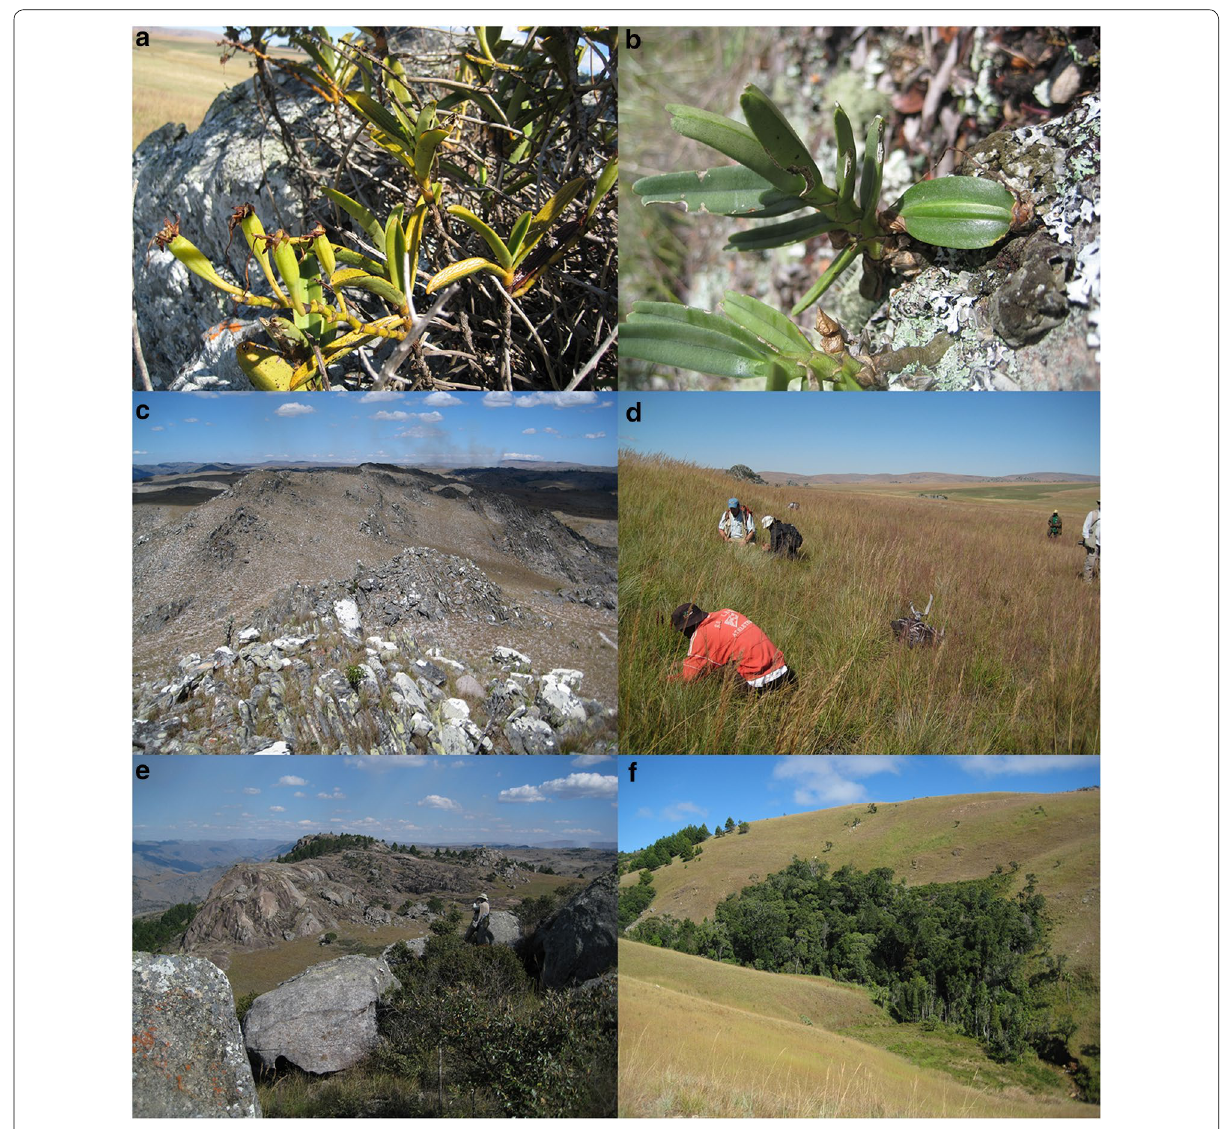
Fig. 1 Orchids and their habitats in Itremo, Central Highlands, Madagascar. a Aerangis ellisii and b Angraecum rutenbergianum with near-mature seed capsules; c rocky montane grassland; d savannah; e inselberg; f gallery forest. Note smoke visible in tile ( c ) as a result of extensive grass